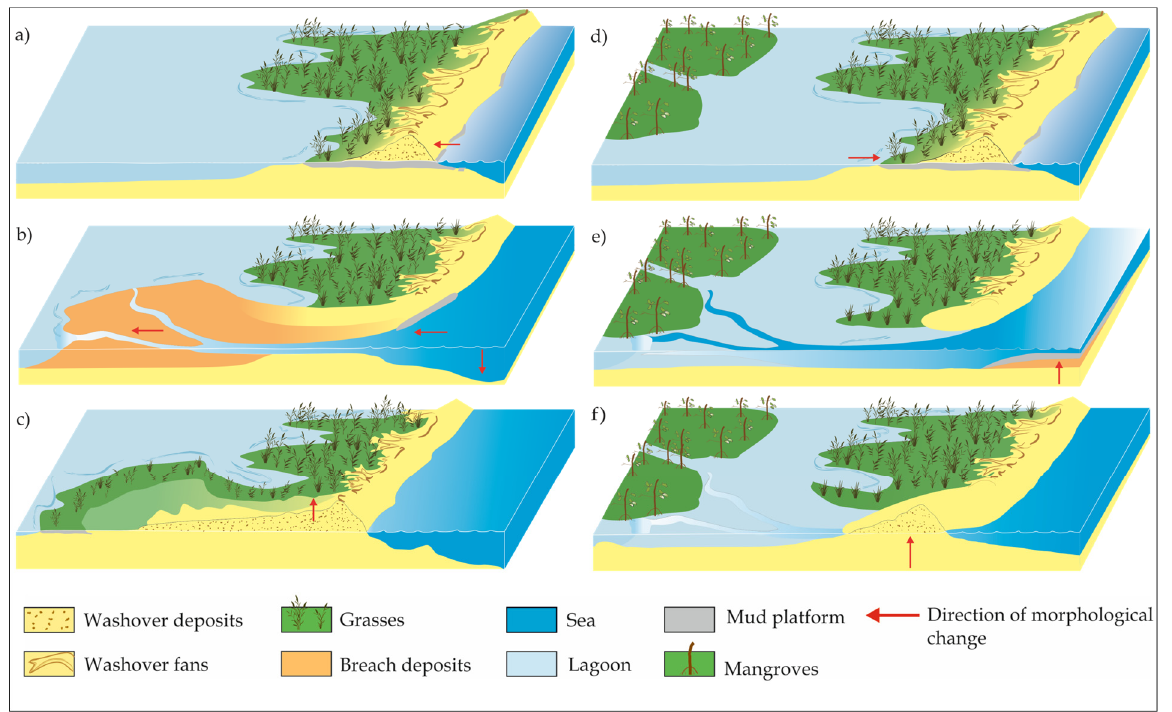
Figure 15. Three-phase conceptual model of barrier evolution driven by an oceanographic breaching (left) and high discharge of river (right). Left side: ( a ) shoreline retreat and negative sediment balance prevail before the breaching; ( b ) depositional lobe results from the landward mobilization of sediment during the breaching, and ( c ) healing is followed by barrier aggradation and stabilization of the lagoon deposit, favored by colonizing vegetation species. Right side: ( d ) increased river discharge causes high lagoon water levels landward of the unbreached barrier; ( e ) breaching from the landward side causes subaqueous deposit seaward and aggradation of the shoreface, ( f ) followed by healing process and reduction in the lagoon size. Red arrows indicate the direction of significant morphological change (Modified from Z ă inescu et al. [15]. ( a – c ) are reproduced from Z ă inescu et al. [15], Figure 12).